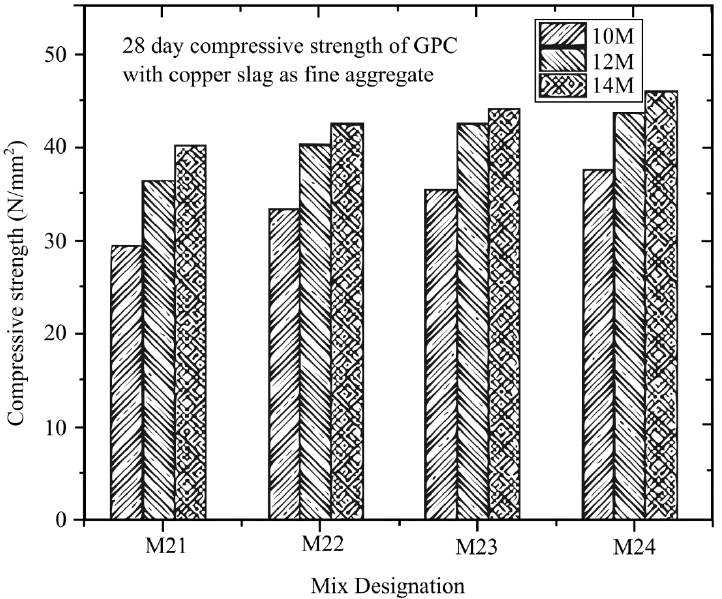
Figure 16. Different molarities in the mix design of GPC and copper slag at 28 days [145] .